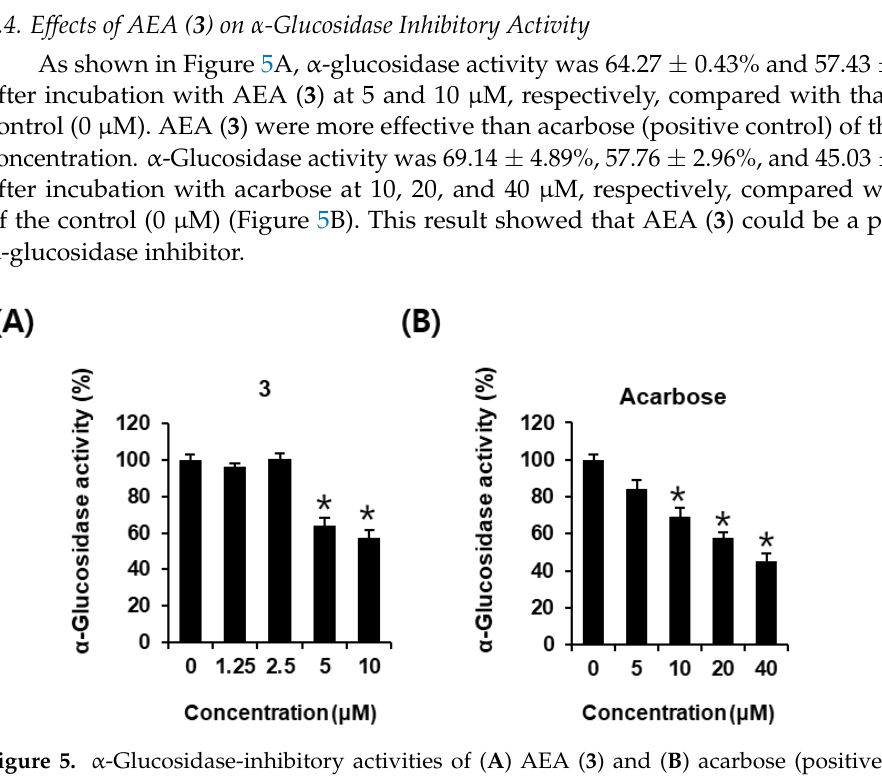
Figure 4. Effects of AEA ( 3 ) on the protein expression levels of phospho-insulin receptor substrate-2 (P-IRS-2) (Ser731), IRS-2, phospho-phosphatidylinositol 3-kinase (P-PI3K), PI3K, phospho-Akt (P-Akt) (Ser473), and Akt, and pancreatic and duodenal homeobox-1 (PDX-1) in INS-1 cells. ( A ) Protein expression levels of P-IRS-2 (Ser731), IRS-2, P-PI3K, PI3K, P-Akt (Ser473), Akt, pancreatic and duodenal homeobox-1 (PDX-1), and glycer-aldehyde 3-phosphate dehydrogenase (GAPDH) in INS-1 cells treated or untreated with 2.5 µ M, 5 µ M, and 10 µ M AEA ( 3 ) for 24 h. ( B – E ) The bar graph presents the densitometric quantification of Western blot bands ( n = 3 independent experiments, * p < 0.05, Kruskal–Wallis nonparametric test). Data represent the mean ± SEM.